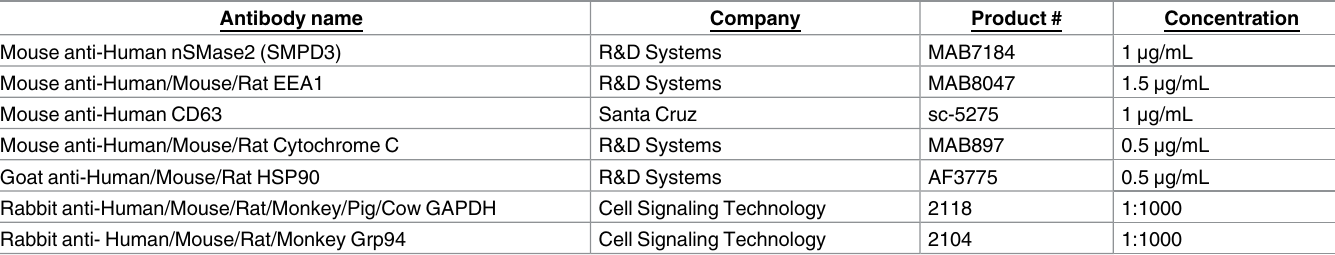
Table 1. Antibodies used for immunoblot